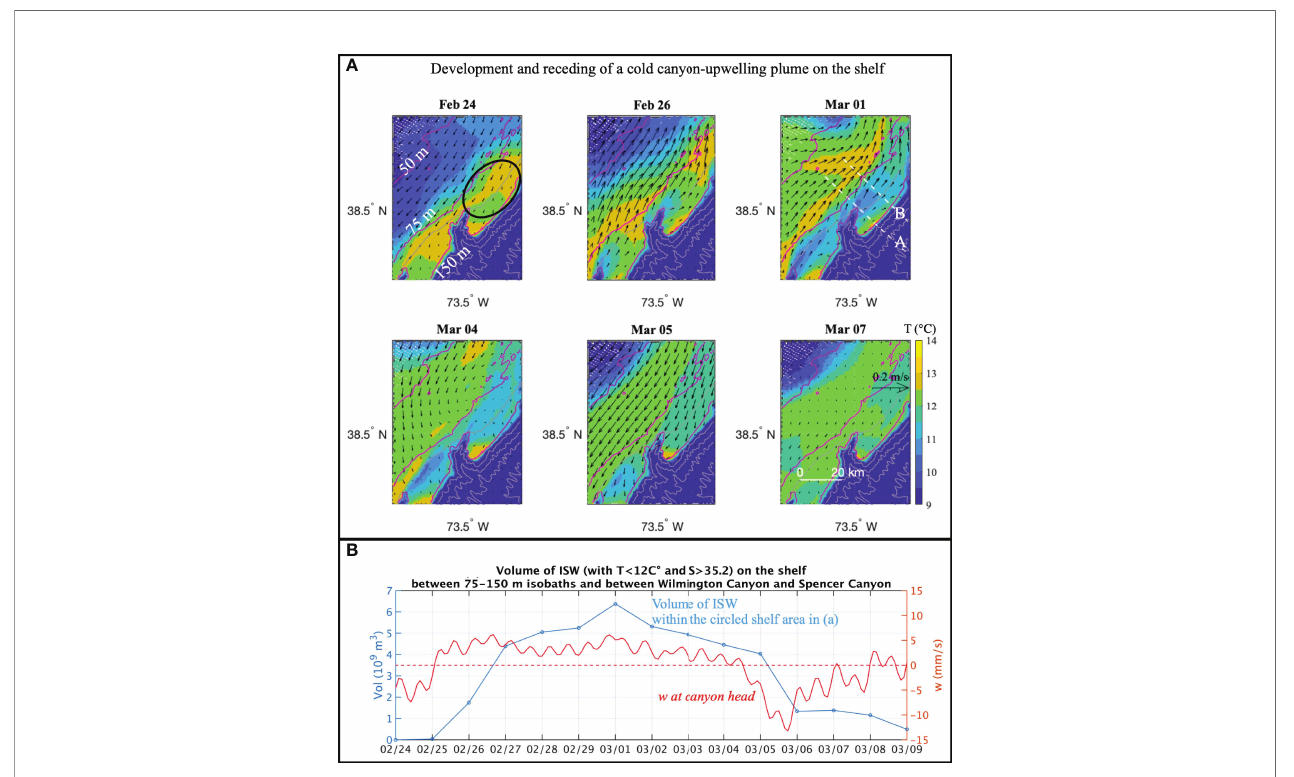
FIGURE 10 | (A) Daily mean temperature and horizontal velocity vectors calculated for the model layer right above the sea fl oor. A canyon-upwelled dense water over fl ow consisting of cold ISW developed on the shelf northeast of Wilmington Canyon during the upwelling phase, and the dense water receded from the shelf during the downwelling phase. (B) Daily mean volume of ISW (blue line) calculated within the circled shelf area northeast of Wilmington Canyon (between 75-m and 150-m isobaths). Red line is the 2-hourly vertical velocity at the canyon